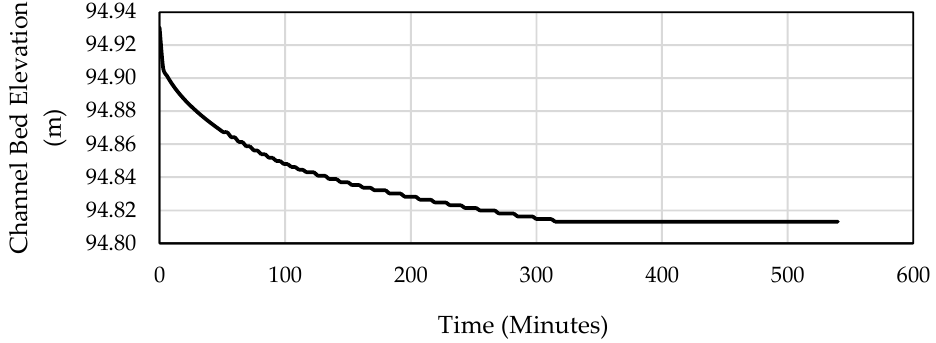
Figure 14. The sediment time series to flush the sediment deposited in station 133.6. The straight line of the curve suggests that all of the sediment has been flushed.